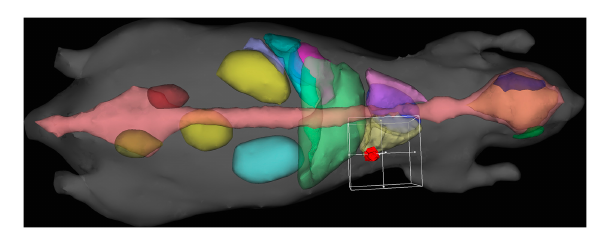
FIGURE 2 | Interactive treatment plan input using Digimouse [28] mesh showing tumor (red), heart (purple), liver (green), lungs (yellow/light purple), and skeleton (pink), with the 10mm DVH bounding